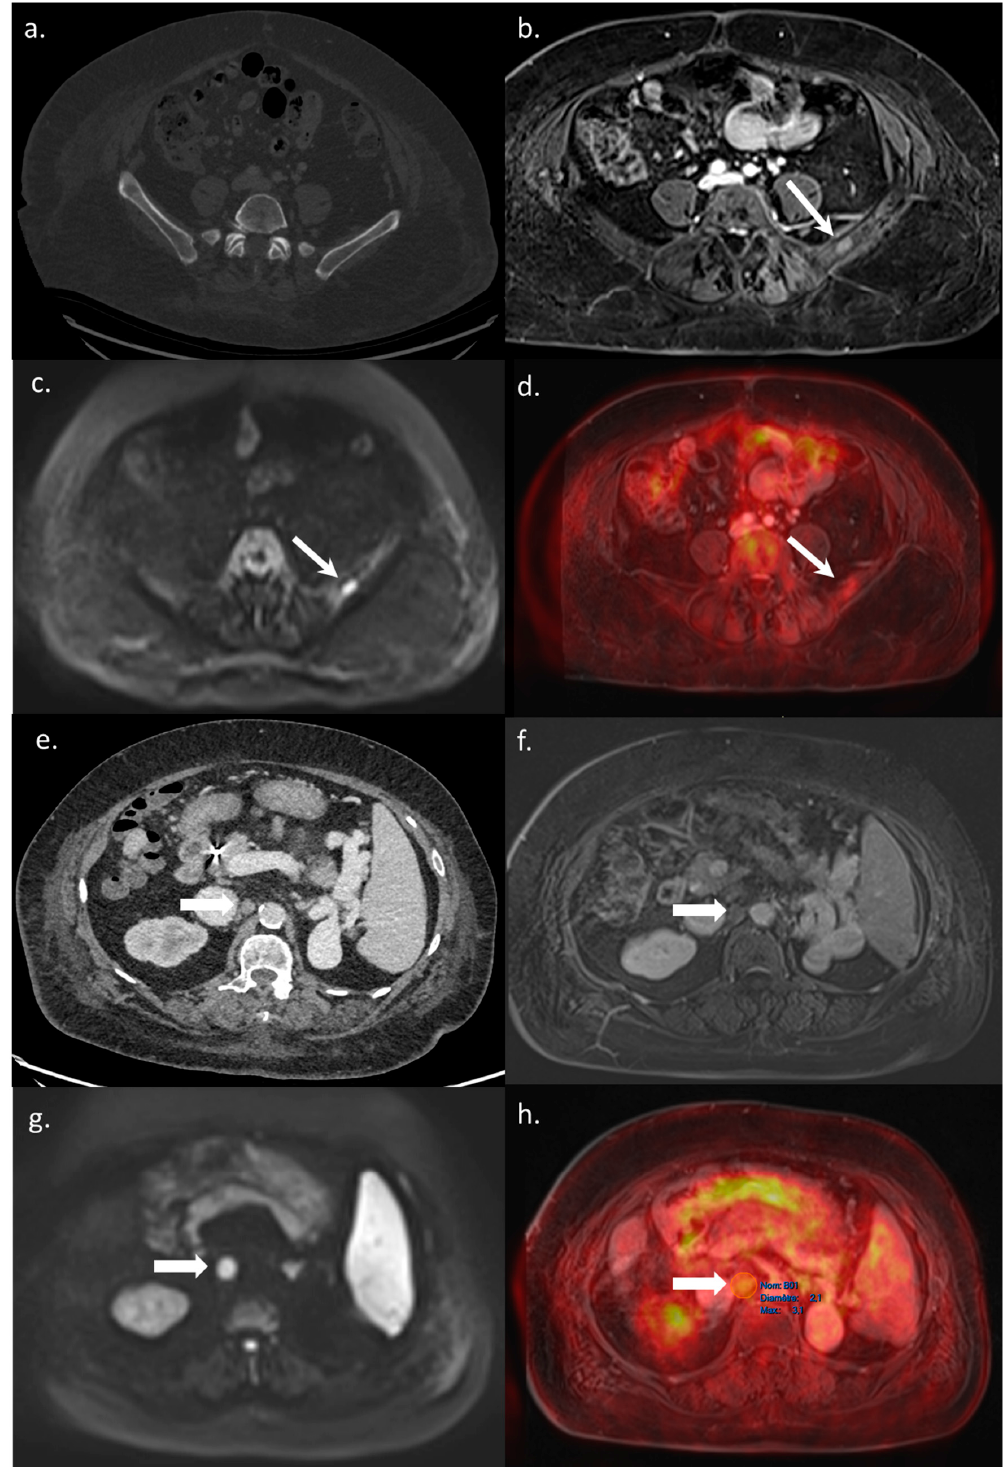
Figure 3. A 65-year-old BCLC C patient referred for a WB-PET/MRI before liver transplantation. On CT-CAP, no bone lesion was visible ( a ). The WB-PET/MRI revealed an infracentimetric bone lesion with enhancement after Gadolinium–chelate injection ( b ), together with hyperintensity on DWI ( c ), and focal hypermetabolism on 18 F-FDG-PET ( d ) leading to the diagnosis of bone metastasis. Moreover, on CT-CAP, a retroperitoneal nonspecific lymph node was observed ( e ), visible on morphologic MRI sequence ( f ). Both diffusion restriction ( g ) and 18 F-FDG hypermetabolism ( h ) were observed leading to the diagnosis of lymph node involvement. The patient was excluded from the liver transplantation list, with a rapidly progressing disease leading to patient death within three